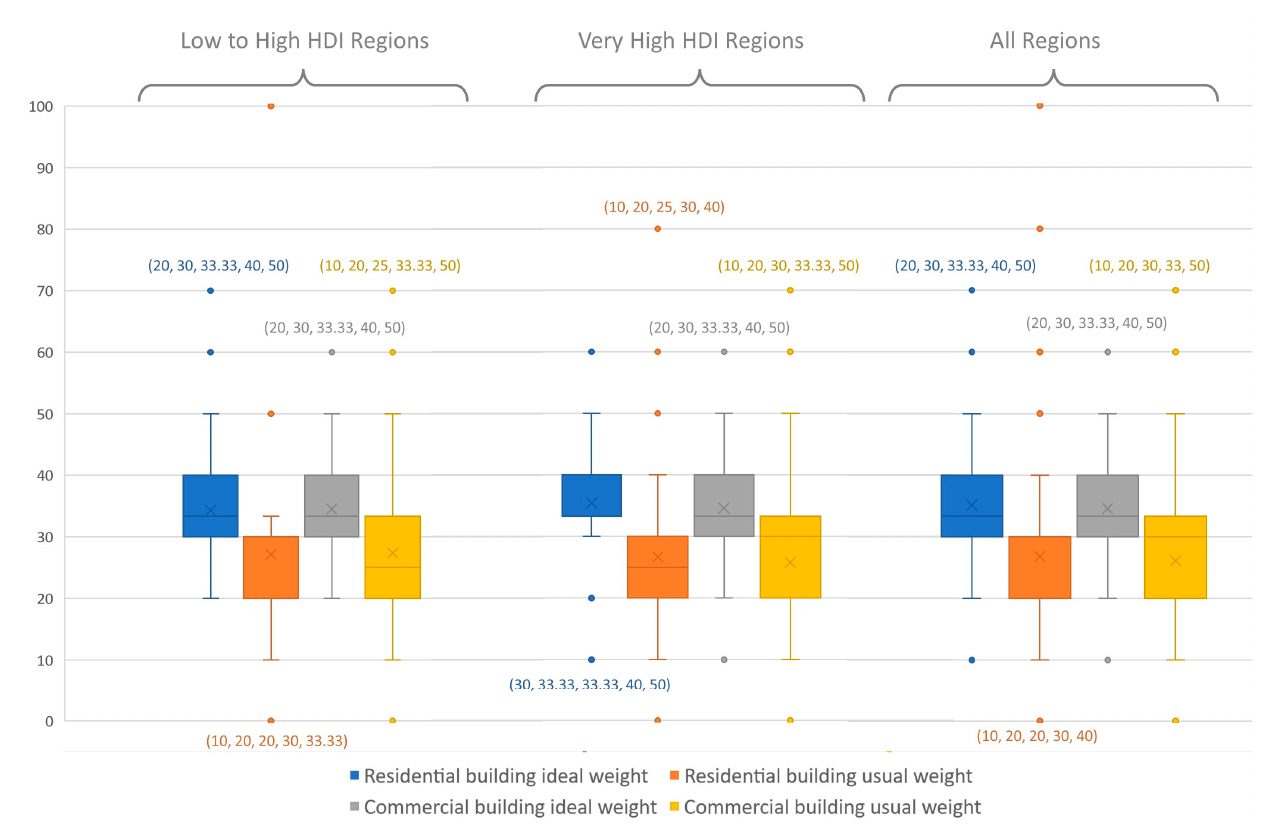
Figure 4. Box whisker plots for environmental sustainability